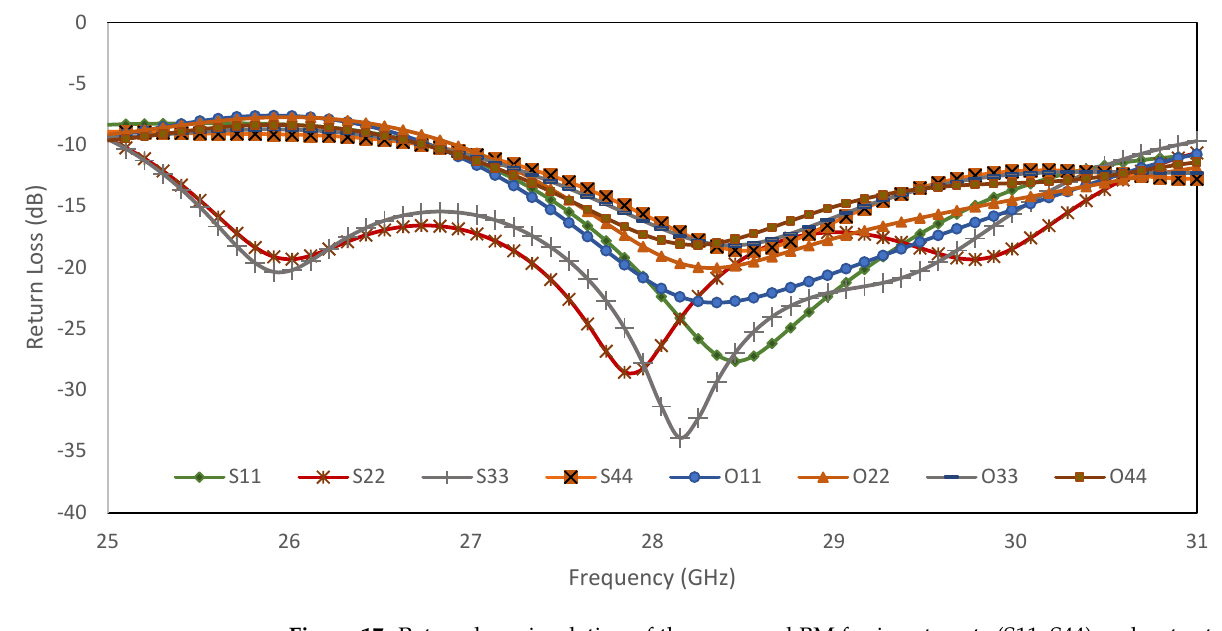
Figure 17. Return loss simulation of the proposed BM for input ports (S11–S44) and output ports (O11–O44).